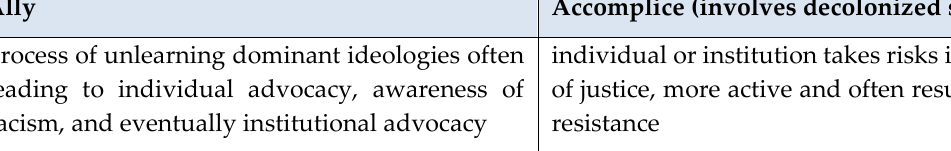
Figure 2 : Differences between allyship and being an accomplice